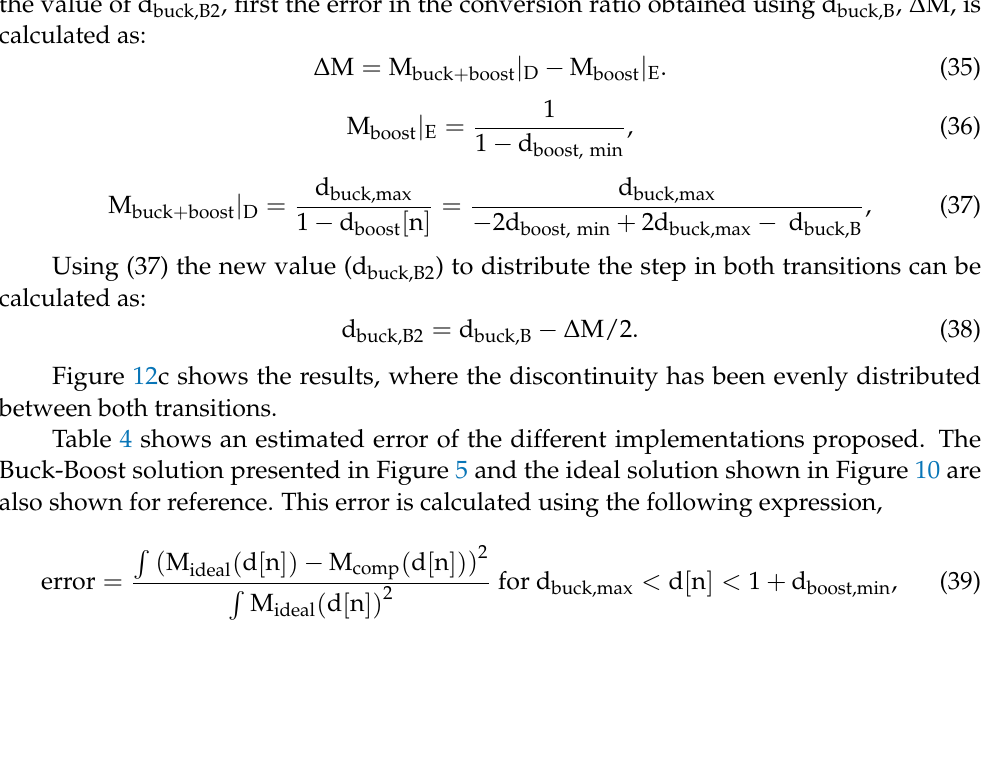
Table 4. Comparison of the conversion ratio obtained with different implementations.